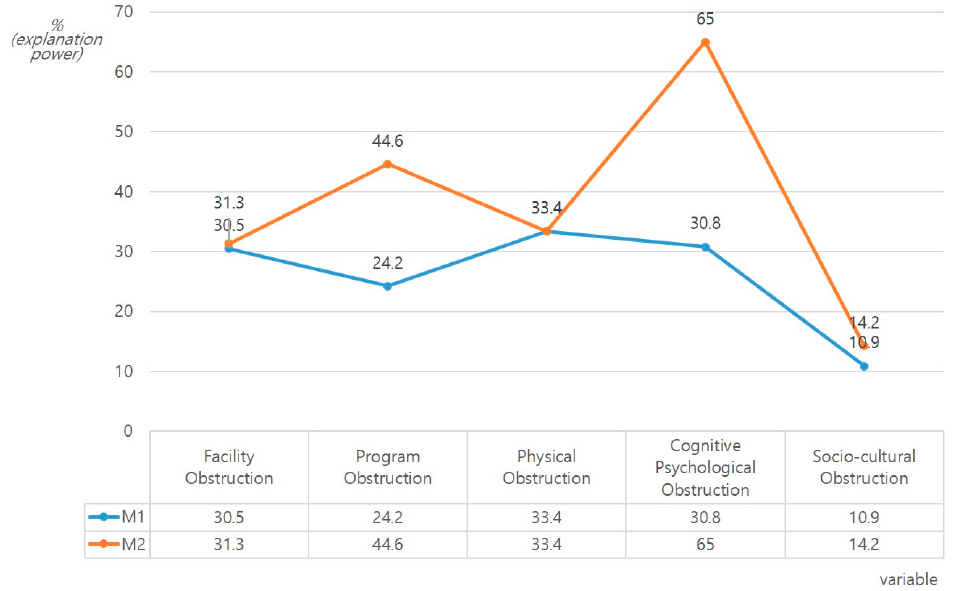
Figure 3. Results of the hierarchical regression analysis for the effects of the physical activity levels and obstruction factors based on the physical activity participation experience (EPE).